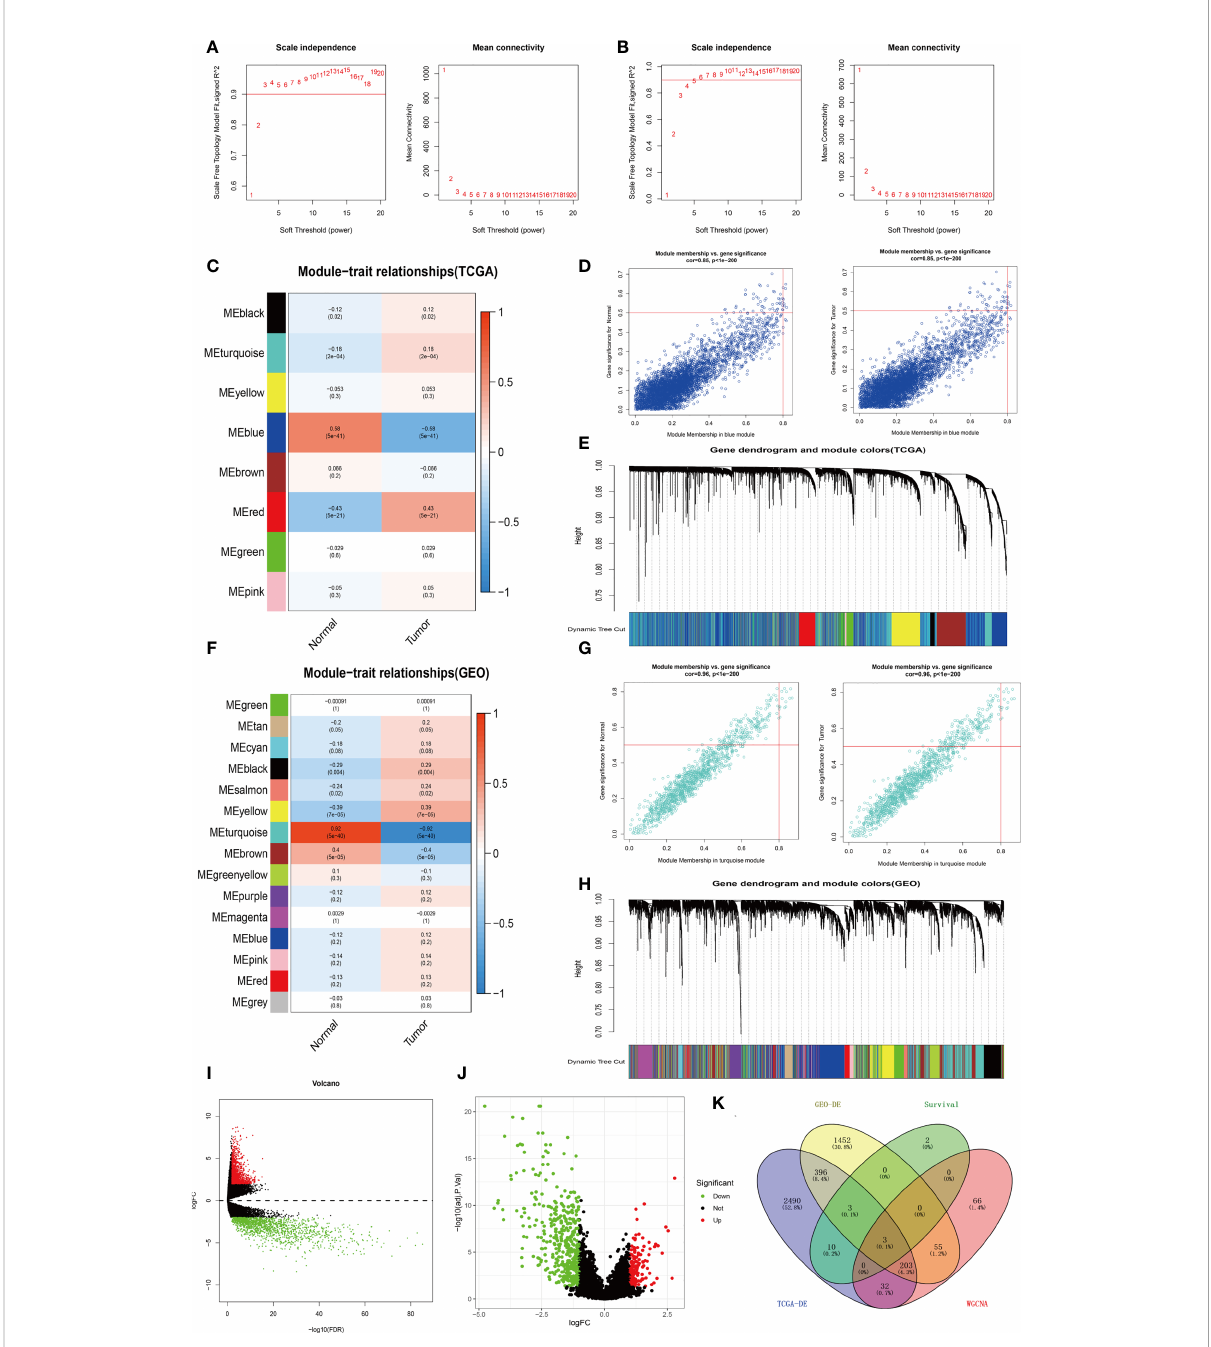
FIGURE 2 Process of screening for target genes. (A) Analysis of network topology for various soft-thresholds (power) in the TCGA dataset. (B) Network topology analysis in the GEO dataset for various soft-thresholds (power). (C) Heat map of the correlation between the TCGA-WGCNA gene clustering module and clinical traits. (D) Correlation of TCGA-WGCNA Blue Modules with clinical traits. (E) Modules for each TCGA-WGCNA gene (each branch represents one gene). (F) A heat map of GEO-WGCNA gene clustering modules that are associated with clinical traits. (G) Correlation of GEO-WGCNA-turquoise modules with clinical traits. (H) Modules corresponding to each gene of GEO-WGCNA (each tree branch represents one gene). (I) Visualization of TCGA-BLCA-mRNA differential expression using a volcano plot. (J) Visualization of GEO-GSE19915-mRNA differential expression analysis volcano map. (K) A Venn diagram depicting the TCGA-BLCA differentially expressed genes, GEO-GSE19915 differentially expressed genes, weighted gene co-expression genes, and TCGA-BLCA intersecting genes with survival-related